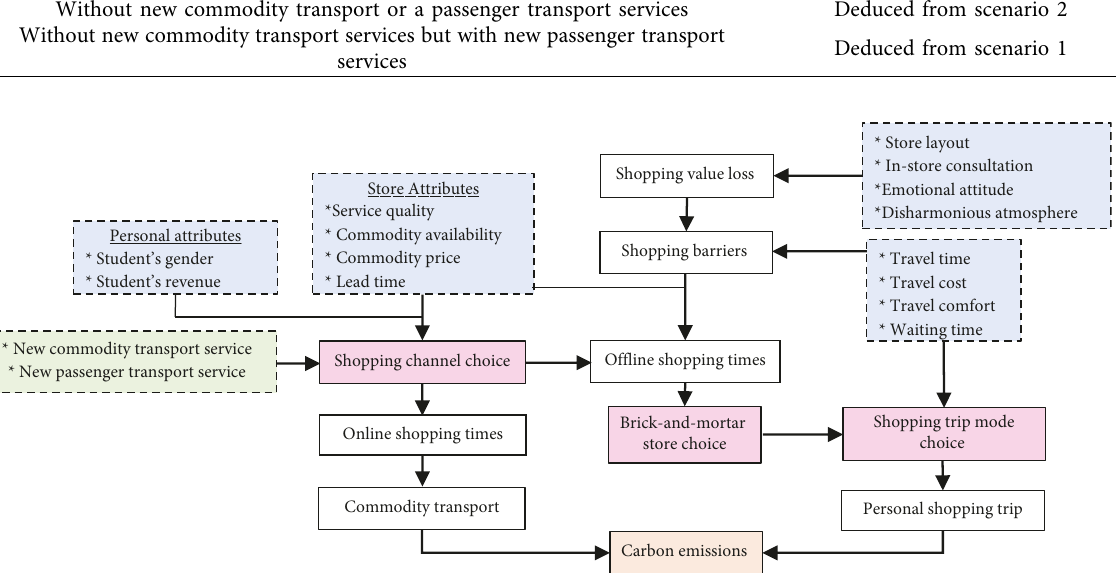
Figure 1: The model structure.